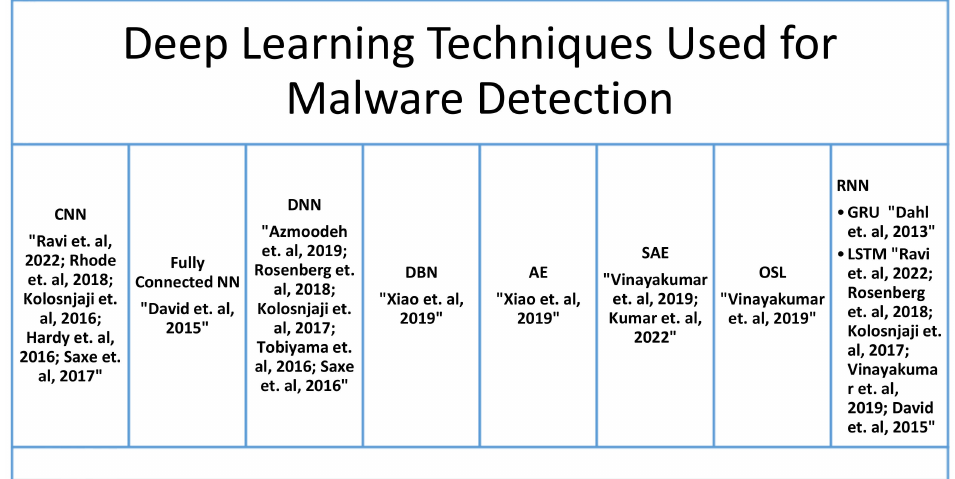
Figure 5. Deep Learning Techniques Used for Malware